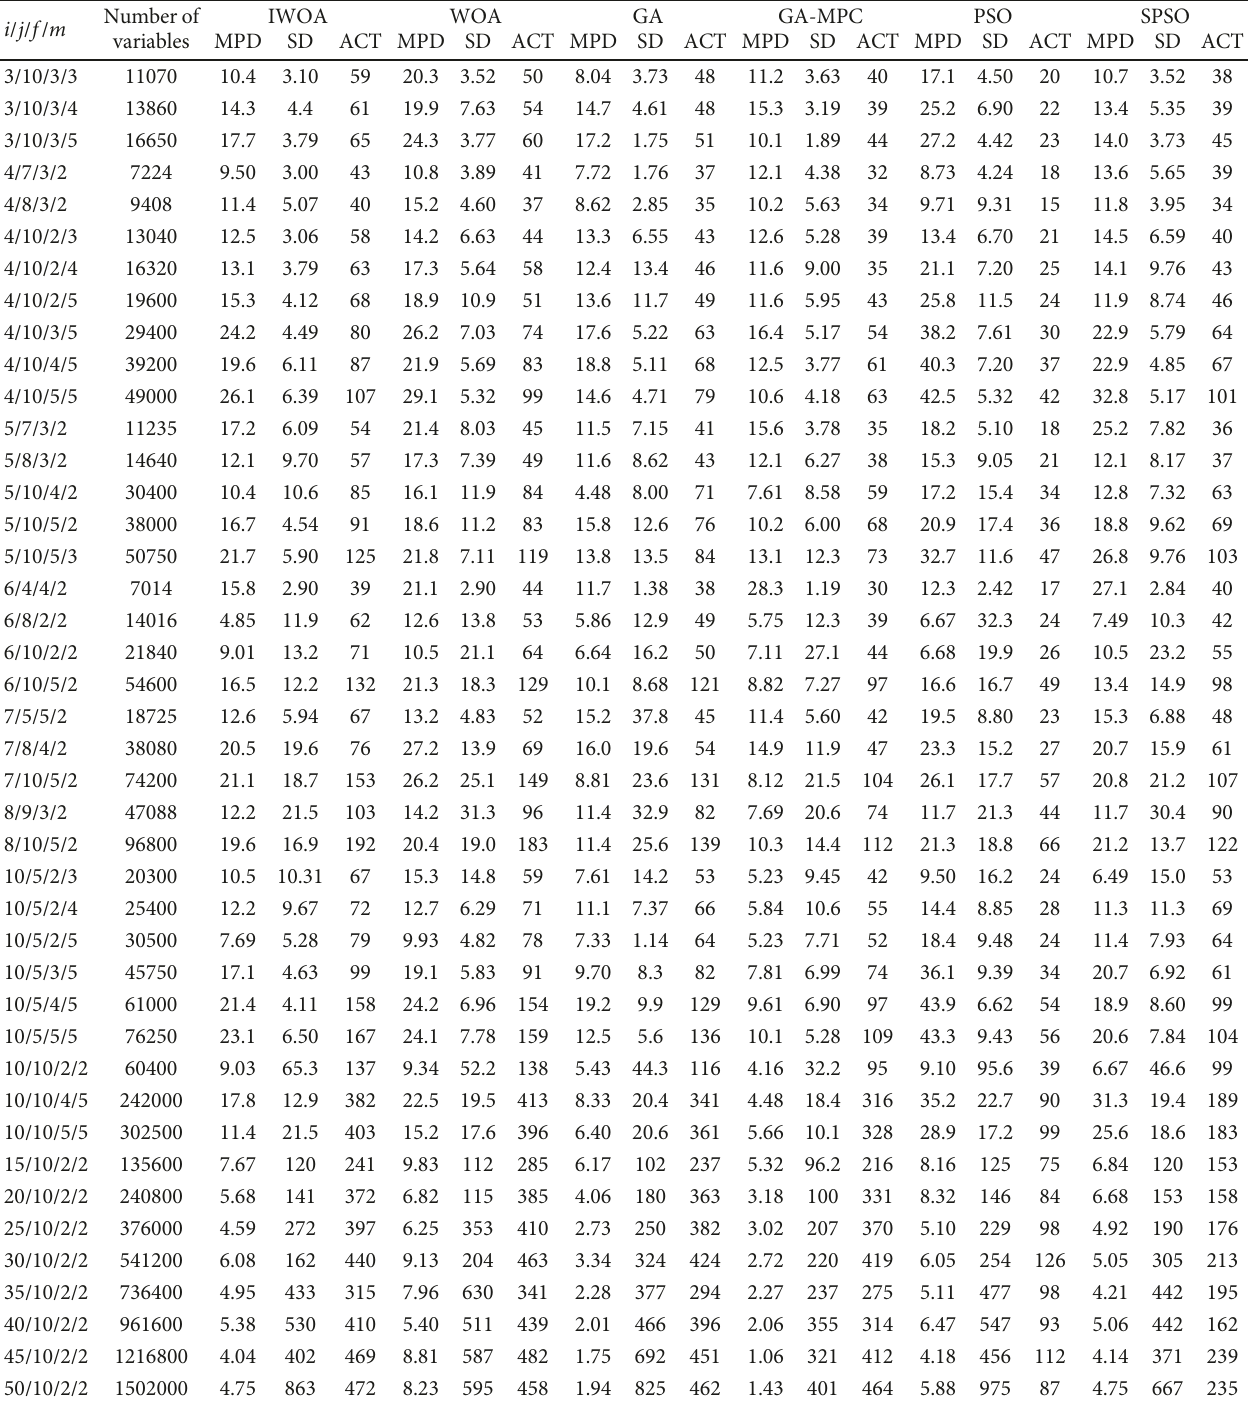
Table 7: Mean PD % , standard deviation SD × 10 8 , and average of CPU time (s) for large-scale